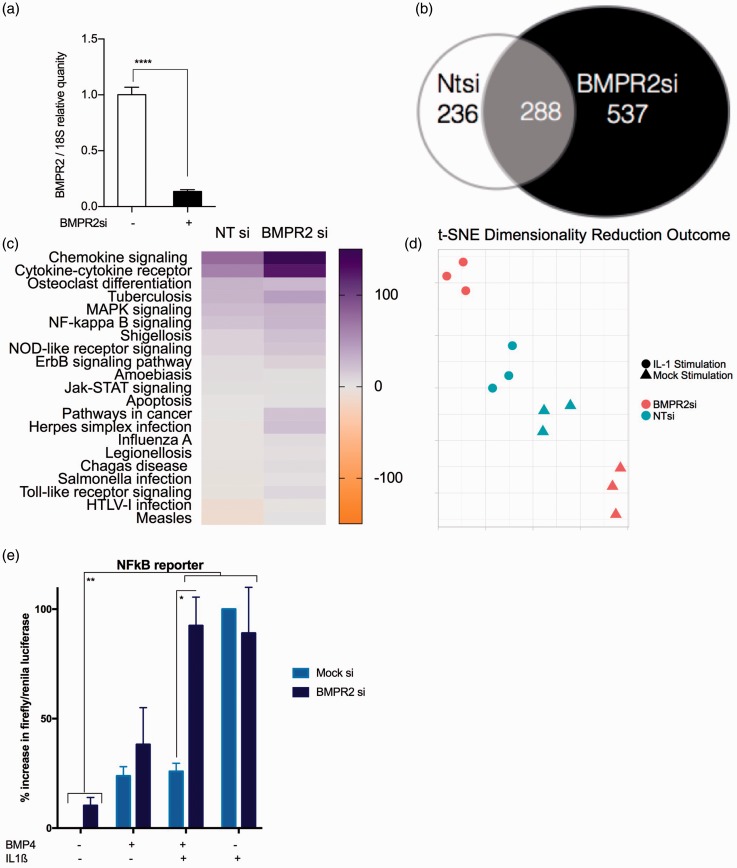
Microarray investigation in PASMC identifies BMPR2 specific changes in IL-1ß transcriptome. qRT-PCR was performed on pooled samples to confirm knockdown prior to arrays (n = 6 for BMPR2si and 3 for NTSi) (a). mRNA expression patterns in PASMC +/– BMPR2 siRNA (n = 9). Ordinary one-way ANOVA with multiple comparisons by Tukey’s post-test (****P < 0.0001). Changes in mRNA showing log2 fold-change of > 1 with adjusted P value ≤ 0.05 (b). Altered pathways discovered using SPIA with significant changes to IL-1ß stimulation in PASMCs +/– BMPR2 siRNA. Pathway changes to generate a heatmap indicating their activation or inhibition in each condition (c). t-SNE analysis was conducted on all arrays mock-transfected and BMPR2 si-transfected data-points for dimensionality reduction and shows data with multiple feature correlation in two dimensions (d). PASMC were co-transfected with Cignal NFkB reporter plasmid and NTsiRNA or BMPR2 siRNA and stimulated with BMP4 +/– IL-1ß for 48 h (e). Results were normalized to renila expression in same plasmid and then expressed as percentage of IL-1ß treated positive controls. Two-way ANOVA with Tukey post-test correction (*P < 0.05, **P < 0.01).